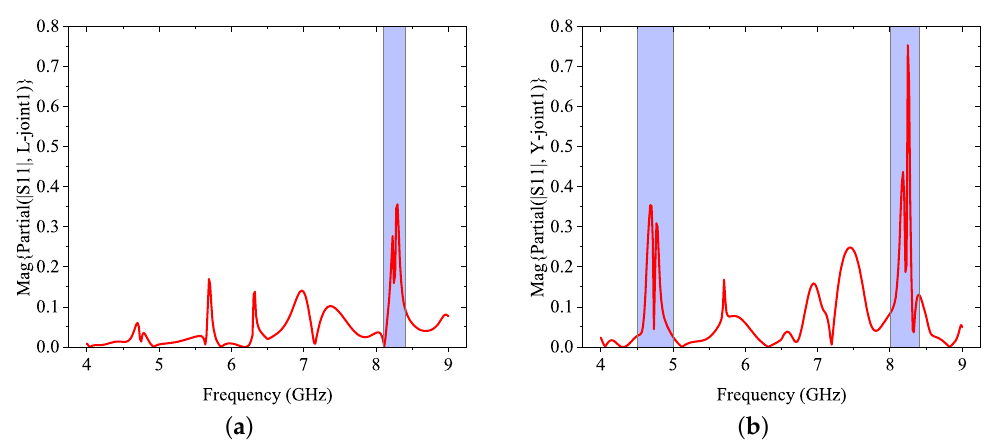
Figure 4. Parameter sensitivity of Y joint 1 and L joint 1 . ( a ) Magnitude of the partial derivative of S 11 over L joint 1 ; and ( b ) Magnitude of the partial derivative of S 11 over Y joint 1 . Thirdly, a second joint is added on the right of the ring slot as shown in Figure 5. Considering the bottom right corner of the ring slot as a reference point, the distance between joint2 and the reference point X joint 2 and the length of joint2 L joint 2 are also swept in HFSS simulation in the range of 0–3 mm and 0–8 mm, respectively.